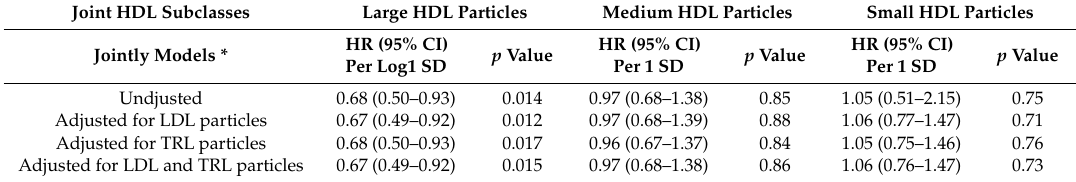
Table 4. Association Between Joint HDL Subclasses and Risk of Developing PTDM in 351